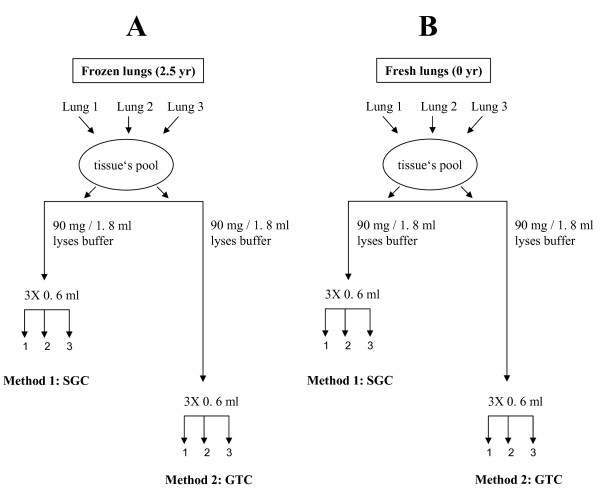
Schematic representation of experimental plan. A tissue pool has been created by combining lung 1, lung 2, and lung 3, respectively, which were obtained from either frozen or fresh samples. Pool of frozen or fresh tissue was divided in two equal parts, one for the SGC and another for the GTC technique. To test technique's reproducibility, each divided part was sub-divided into three identical parts (triplicate approach).